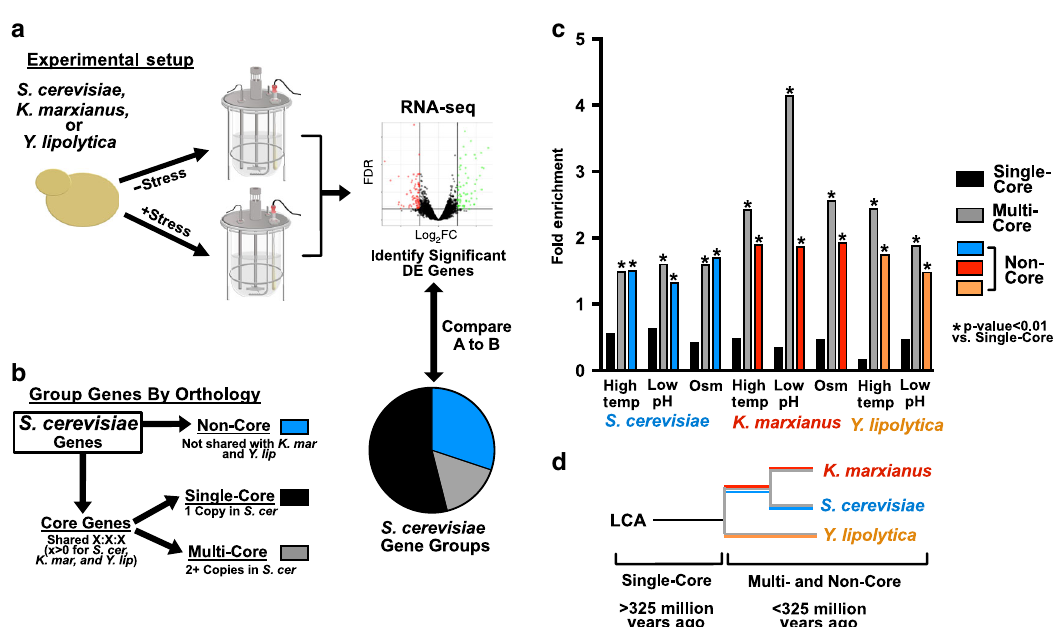
Fig. 1 Stress adaptation responsive genes are enriched for duplicated and non-conserved genes. a S. cerevisiae , K. marxianus , and Y. lipolytica were cultivated in chemostats in standard conditions or in the presence of stress (elevated temperature, low pH, or KCl). RNAseq was performed followed by differential expression analysis. b The protein-coding genes of each organism were compared to infer orthology using OrthoFinder. The resulting gene groups for S. cerevisiae are shown, with single-copy orthologous genes (Single-Core [black]), multi-copy orthologous genes (Multi-Core [gray]), and genes that were not shared (Non-Core [blue]). c The number of differentially expressed (log 2 FC > 1, FDR < 0.01) mRNAs were divided by the total number of detected mRNAs inside of each ortholog group. Values were normalized to the overall DE gene # divided by the total genes measured, p -values were calculated using a two-sided Fisher ’ s exact test. d A simpli fi ed phylogenetic tree. Single Core orthologs are predicted to originate from a Last Common Ancestor >325 million years ago. Multi- and Non-Core Genes are predicted to have duplicated or arisen de novo <325 million years